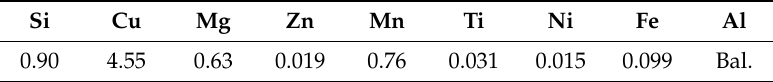
Table 1. Chemical composition of 2A14 aluminum alloy (mass fraction,%).